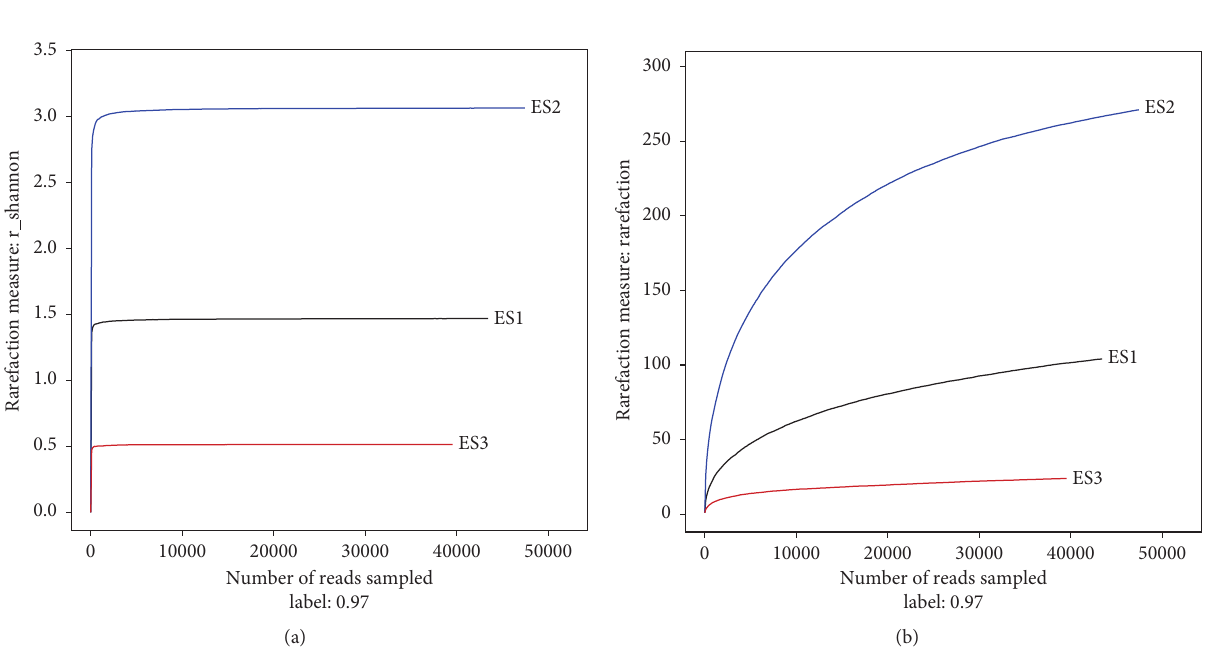
Figure 1: Evaluation of HTS data based on the ITS1 amplicon. Shannon–Wiener curves show that the fungal diversity levels off with deeper sequencing in all three E. sinensis samples (a). Rarefaction curves show that the abundance of fungal species increased with the number of reads